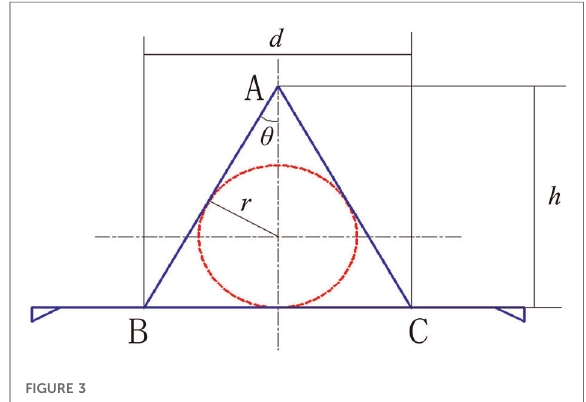
FIGURE 3 Geometrical model of the A-T fl ap.